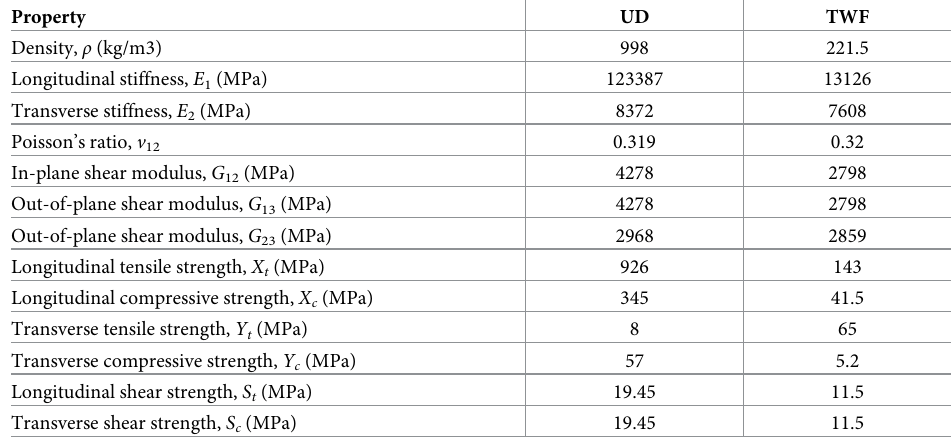
Table 3. Mechanical properties of UD T350/EP-6001 and TW T300/EP-6001 composite.